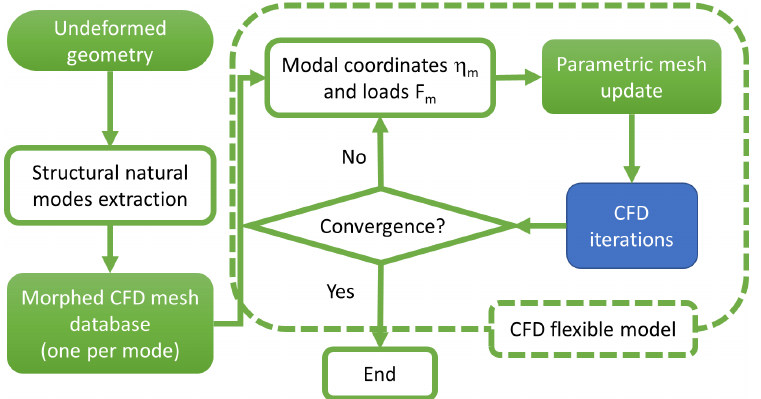
Figure 6. Workflow of a modal FSI